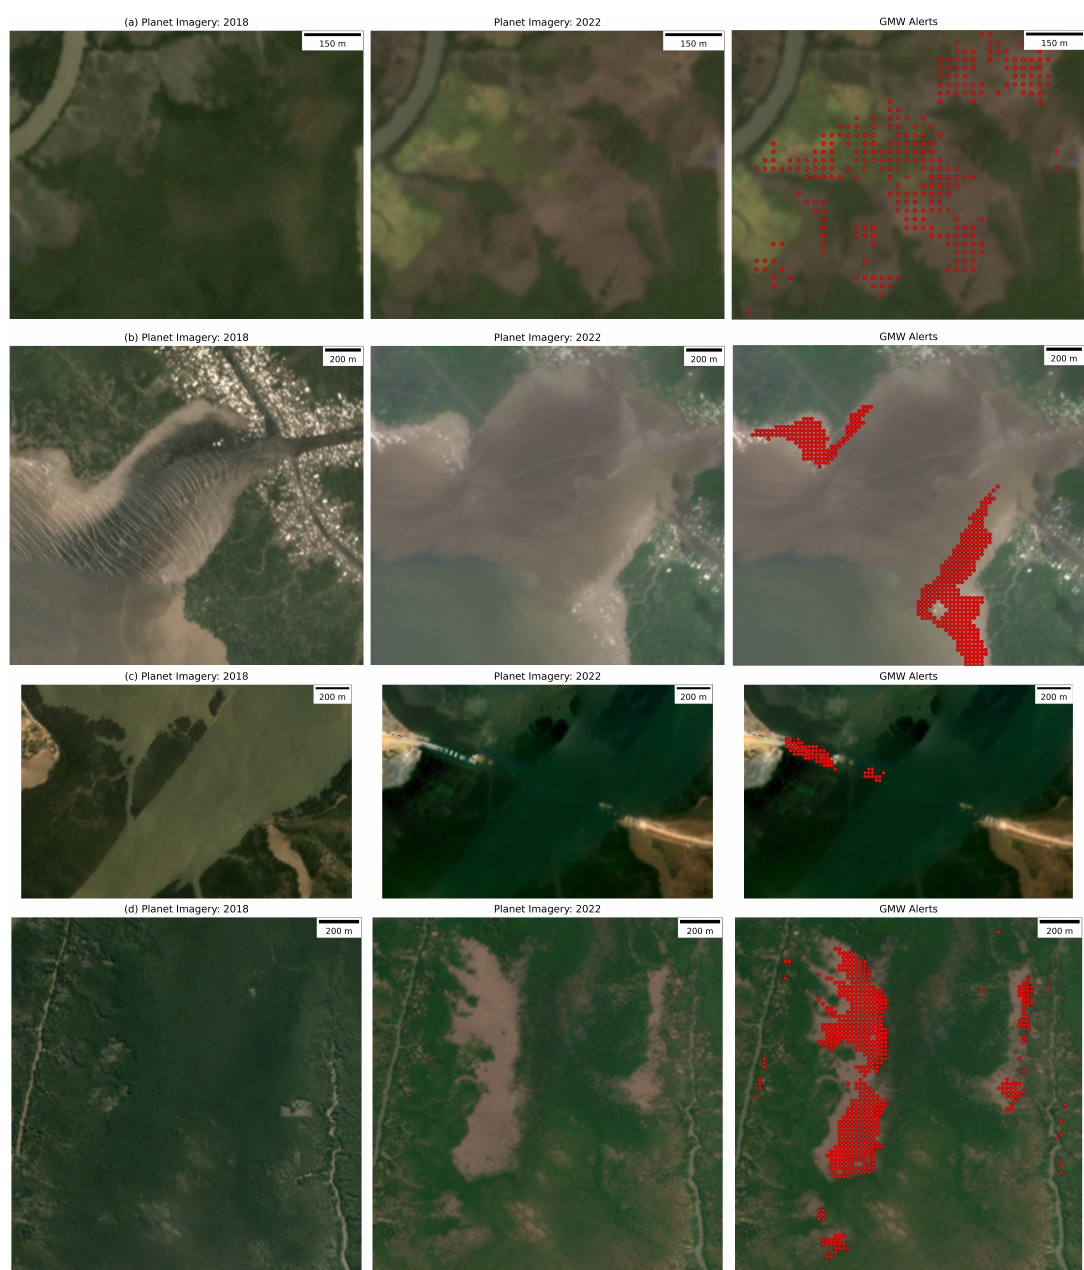
Figure 8. Examples of the mangrove loss alerts (red dots) for ( a ) agriculture conversion in Guinea- Bissau, ( b ) coastal erosion in Nigeria, ( c ) infrastructure development in Kenya, and ( d ) storm damage in Mozambique. Note, the occurrence of geolocation errors between the Planet imagery and the resulting mangrove loss alerts from the Sentinel-2 data, which are most evident in ( d